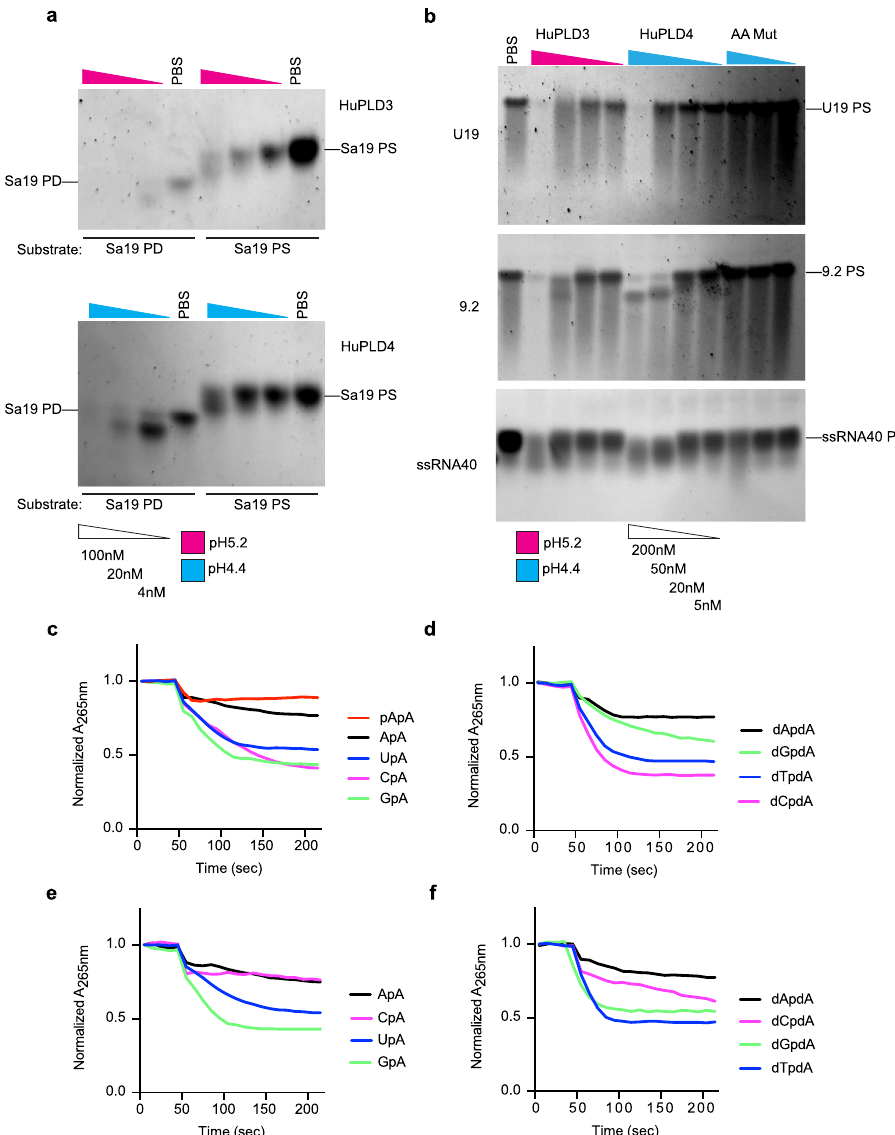
Fig. 4 Speci fi city of RNAse activity of human PLD3 and PLD4. Analysis of digestion of a, b oligoribonucleotides or c – f dinucleotides. In a , substrates were Sa19 phosphodiester (5 ′ -GGACGGAAAGACCCCGUGG-3 ′ ) (Sa19 PD) or its phosphorothioate form (Sa19 PS). In b , substrates were the following phosphorothioate-linked sequences: U 19 , UUUUUUUUUUUUUUUUUUU; 9.2, AGCUUAACCUGUCCUUCAA; ssRNA40, GCCCGUCUGUUGUGUGACUC. The concentration of enzyme and pH of reaction conditions are indicated. Oligonucleotides were at 2 μ M. c – f Dinucleotide assay 68 incubated the indicated ribodinucleotide ( c , e ) or deoxydinucleotide ( d , f ) substrates at 40 μ M with 25 nM of PLD3 ( c , d) or PLD4 ( e , f ) and followed the loss of adenosine absorbance in a linked assay. Experiments in ( a , b ) were repeated twice. Experiments in ( c – f ) were carried out at a range of concentrations as depicted in Supplementary Fig. responses are elevated in some cell types, however TLR7 signaling is not dominant in driving disease in the absence of PLD3 and PLD4.